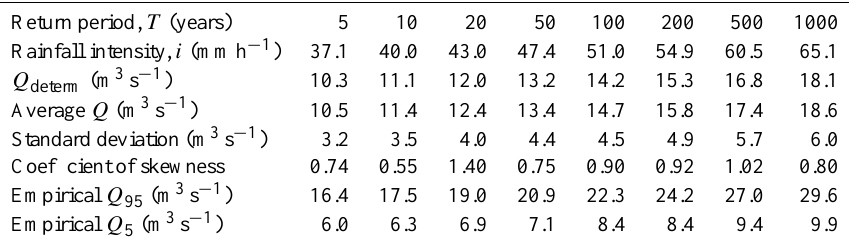
Table 1. Summary of results with the Monte Carlo experiment using the rational method; Q determ is the peak flow value obtained through the deterministic application of the